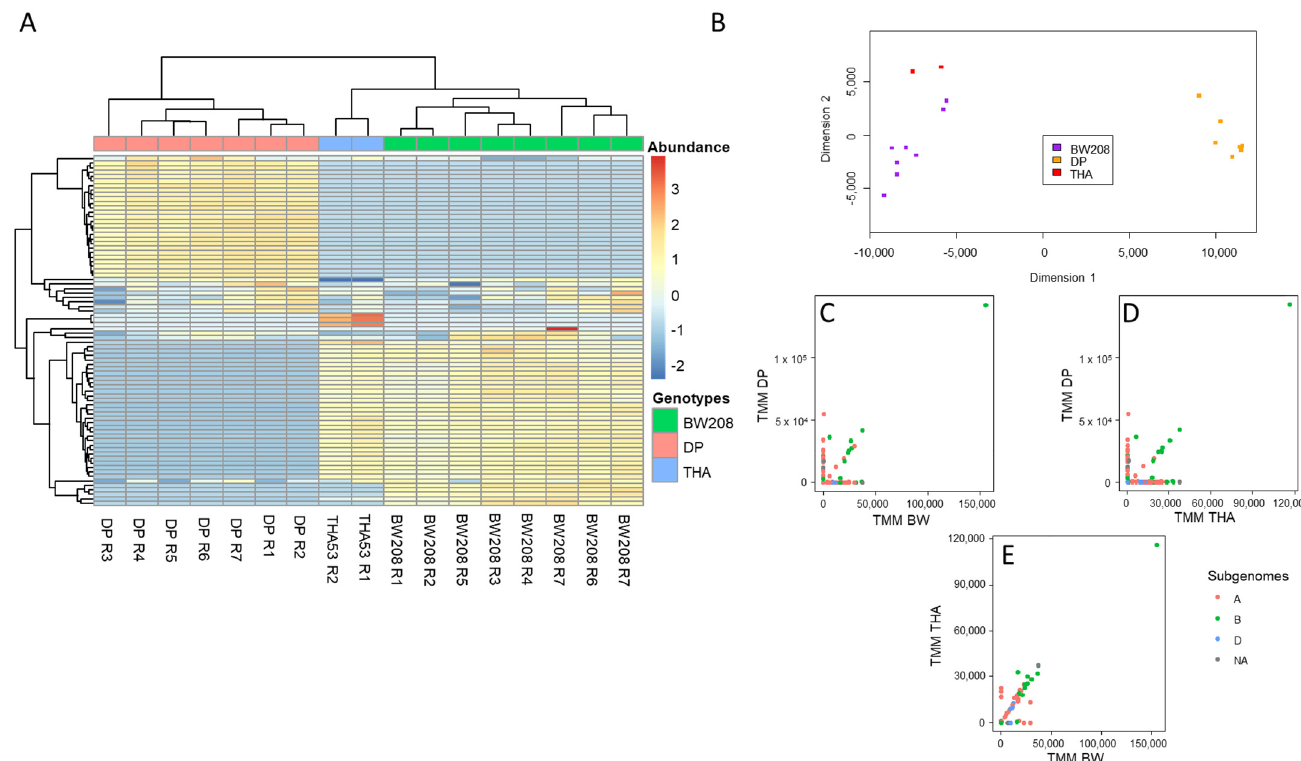
Figure 1. Abundance of α -gliadin Amps between wheat subgenomes A, B, and D in WT lines (BW208, THA53 and DP). ( A ). Heatmap of the abundance of Amps (rows) per WT line (columns). Dendrograms are represented for sequences (left) and WT lines (above). ( B ). Multidimensional scaling (MDS) plot of the Amp abundances for WT lines. ( C ). Comparison of Amp abundances between BW208 (hexaploid) and DP (tetraploid). ( D ). Comparison of Amp abundances between THA53 (hexaploid) and DP (tetraploid). ( E ). Comparison of Amp abundances between THA53 (hexaploid) and BW208 (hexaploid). WT: wild type. DP: Don Pedro. Amps: unique denoised amplicons. NA: Amps not assigned to a subgenome.